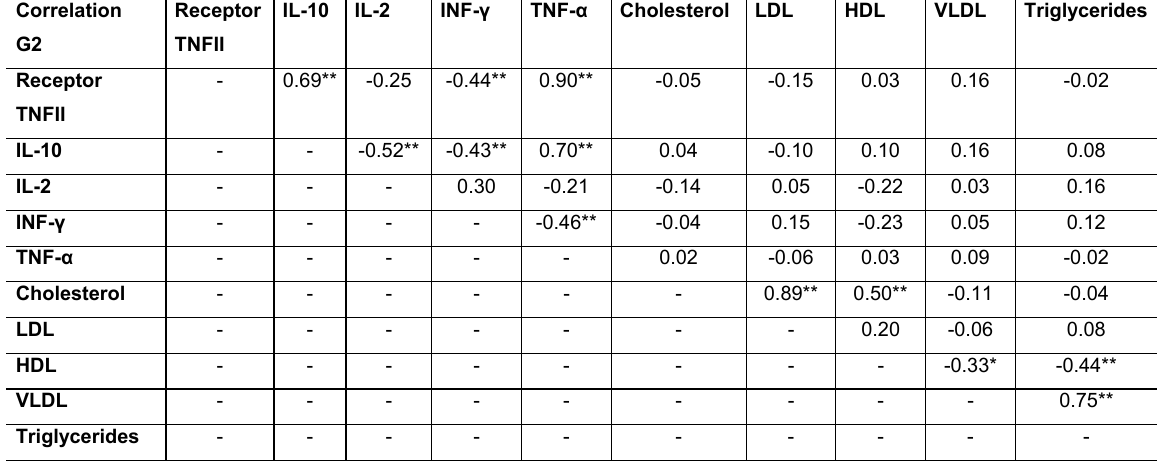
Table 6. Correlations between lipid profile and cytokines in G2 (without